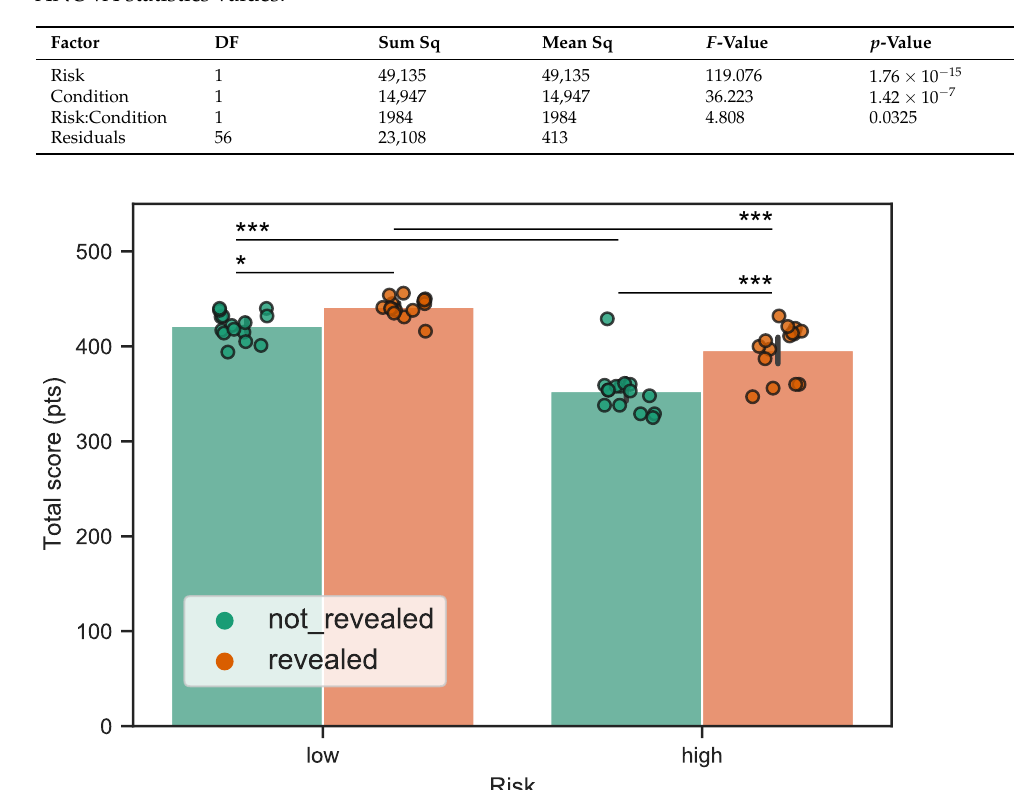
Figure 5. The total score in the experimental sessions. The data are visualized using bar plots with superimposed individual data for each participant. The error bars indicate confidence intervals of 95% computed using bootstrapping. The indicators of significant differences obtained from the ANOVA analysis are *: p < 0.05, ***: p <